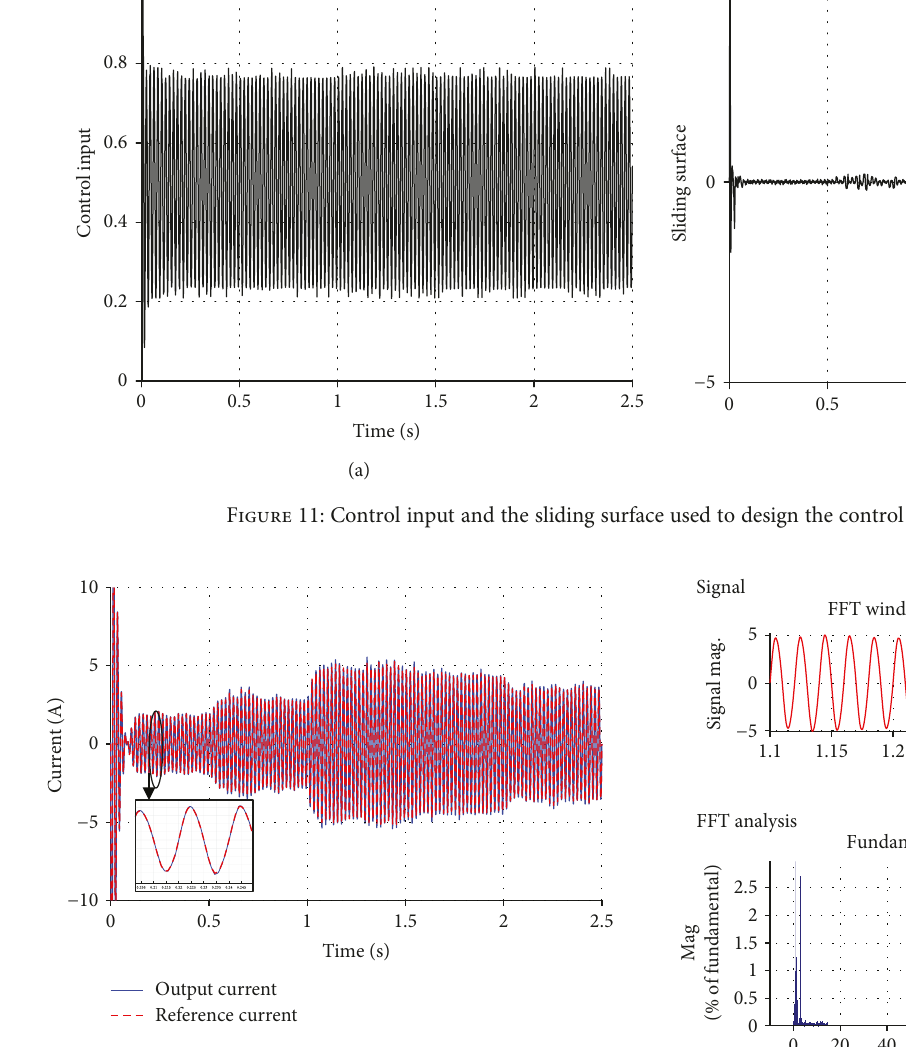
Figure 12: Reference and the controlled output current.